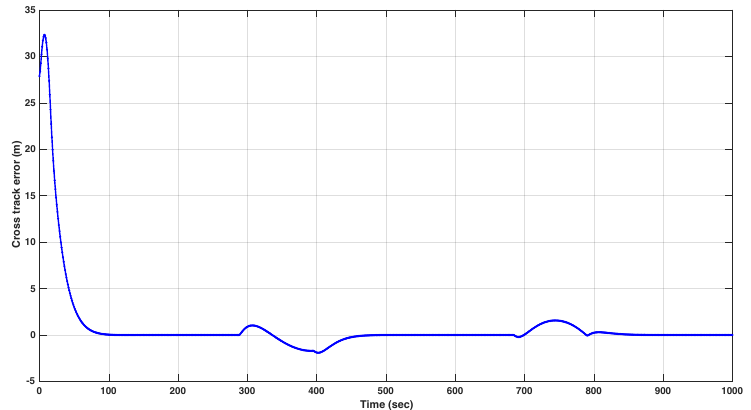
Figure 17. Cross-track error for the simulated